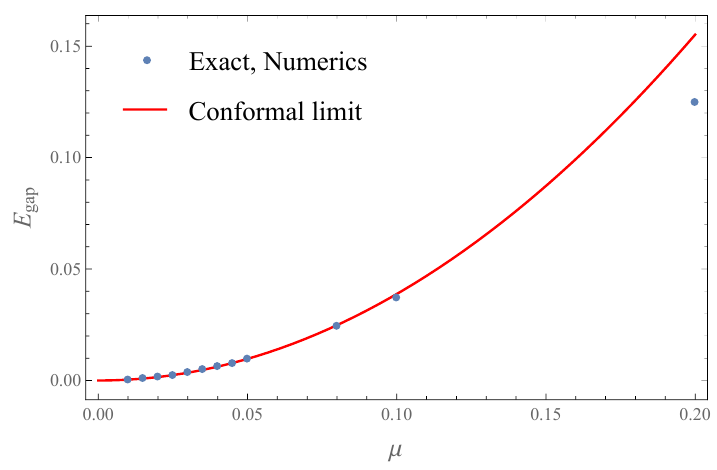
Figure 5 . The plot of the mass gap E gap , which is de(cid:12)ned as the exponential decay rate G ( (cid:28) ) (cid:24) e (cid:0) E gap (cid:28) of the correlation functions, for q = 4 ; J = 1 case. In the conformal limit, the mass gap is given by E gap = 2 (cid:11) (cid:1). For small (cid:22) , the result in the conformal limit agrees with the numerics